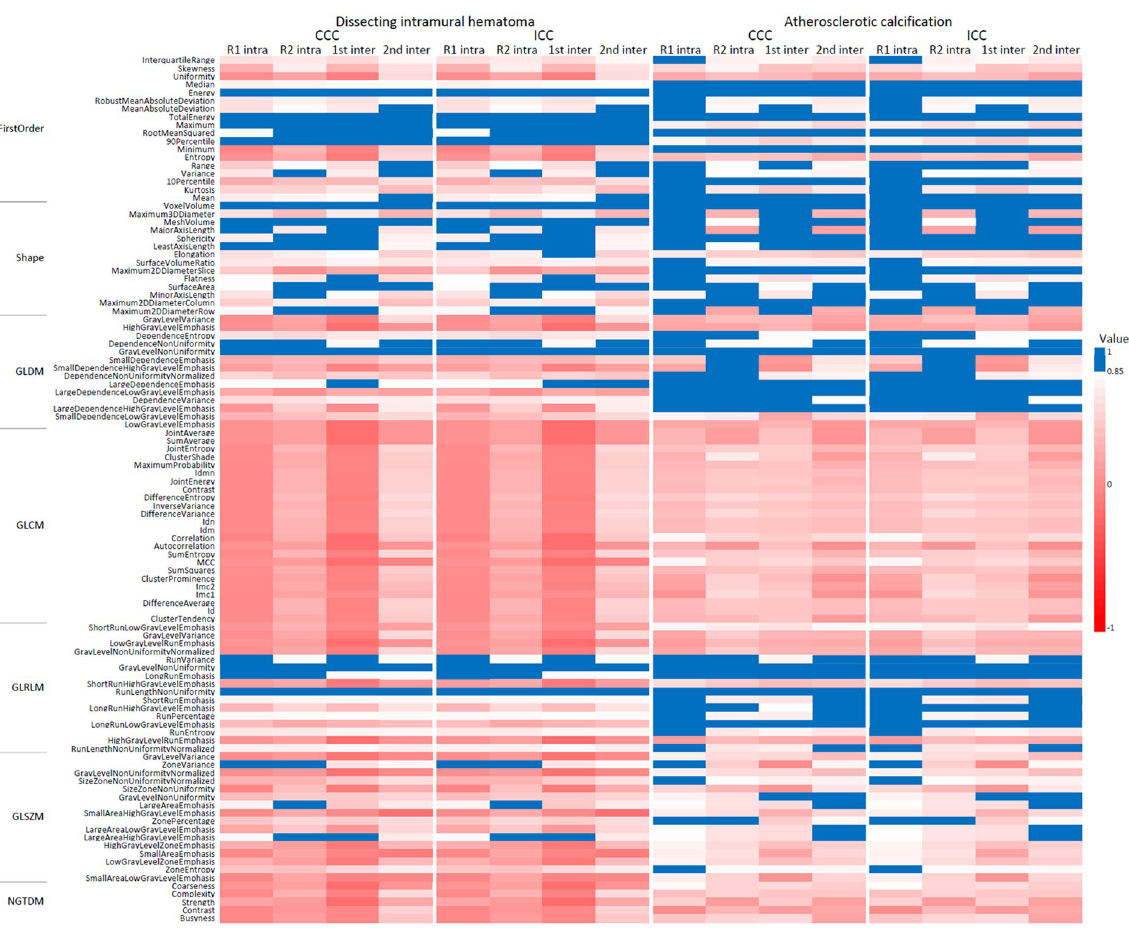
Figure 3. Heatmap of concordance correlation coefficients (CCCs) and intraclass correlation coefficients (ICCs) of individual radiomic features from quantitative susceptibility mapping (QSM) in dissecting intramural hematomas and atherosclerotic calcifications. Blue-colored cells represent stable radiomic features (CCC and ICC > 0.85). CCC concordance correlation coefficient, ICC intraclass correlation coefficient, QSM quantitative susceptibility mapping, GLDM gray-level dependence matrix, GLCM gray-level co-occurrence matrix, GLRLM gray-level run-length matrix, GLSZM gray-level size zone matrix, NGTDM neighboring gray-tone difference matrix. The heatmap was drawn using the Microsoft Excel version